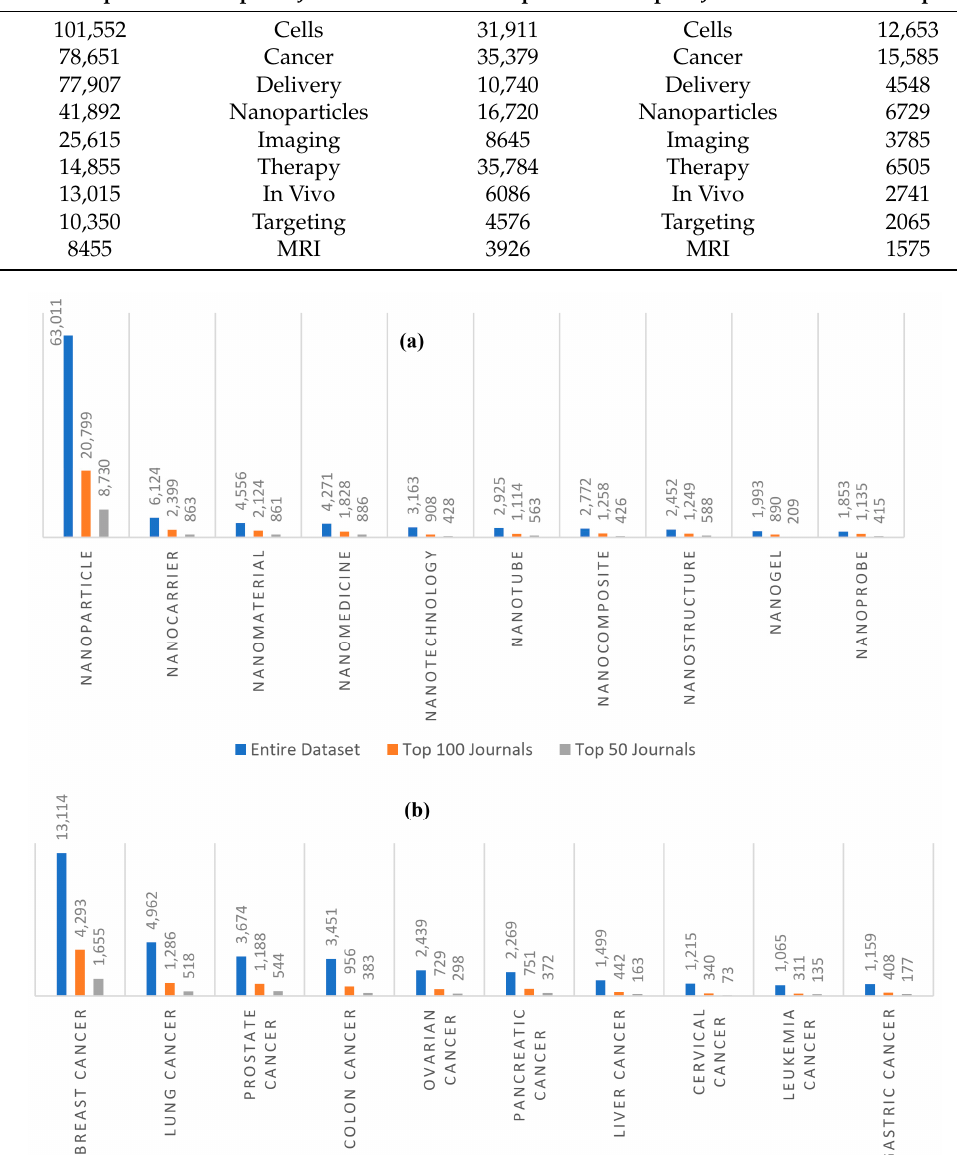
Table 2. Top 10 keywords within the entire dataset, top 100 journals, and top 50 journals in the area of cancer nanotechnology in 2000–2021. Entire Dataset Freq. Top 100 Journals Freq. Top 50 Journals Freq.